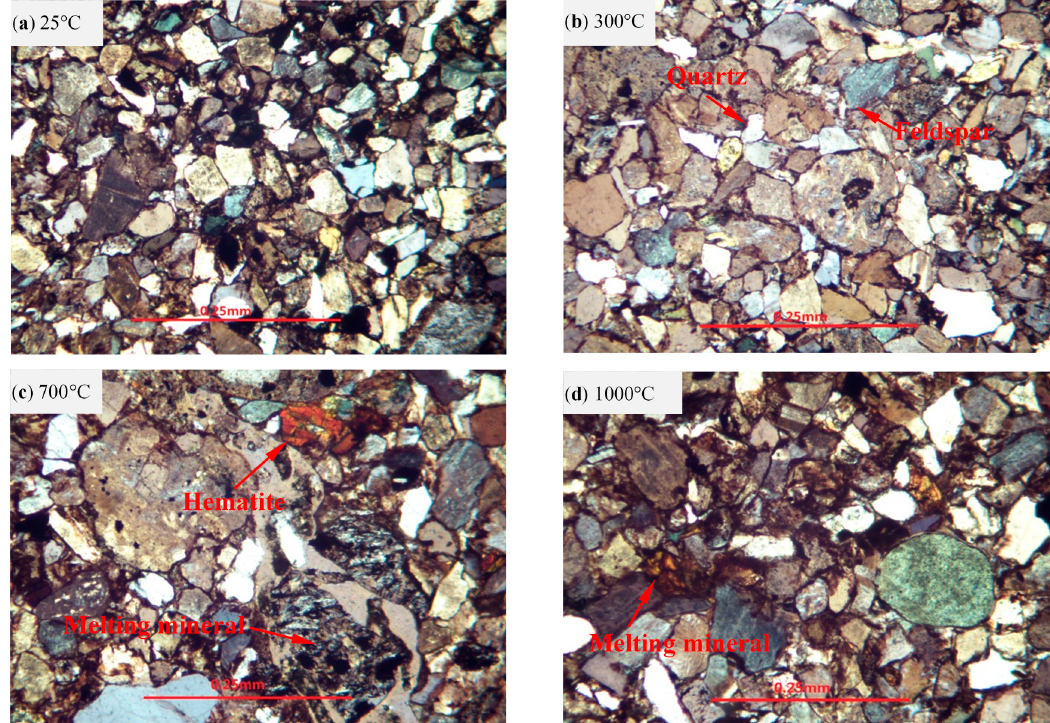
Figure 17. Microscopic structure of red sandstone (optical microscopy) used in this research.